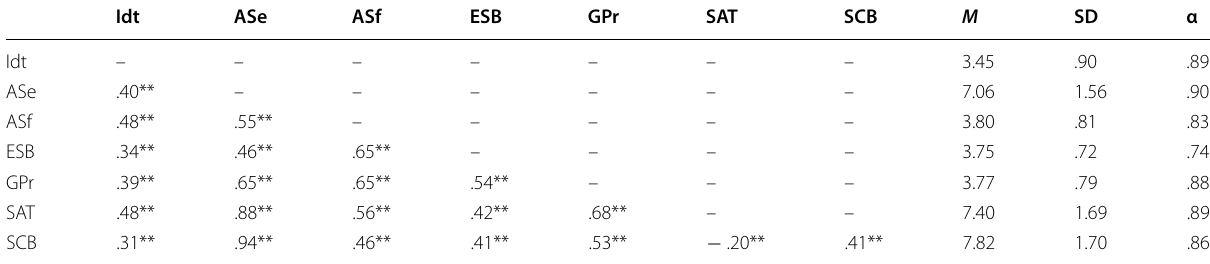
Table 3 Means, standard deviations, and correlations among variables